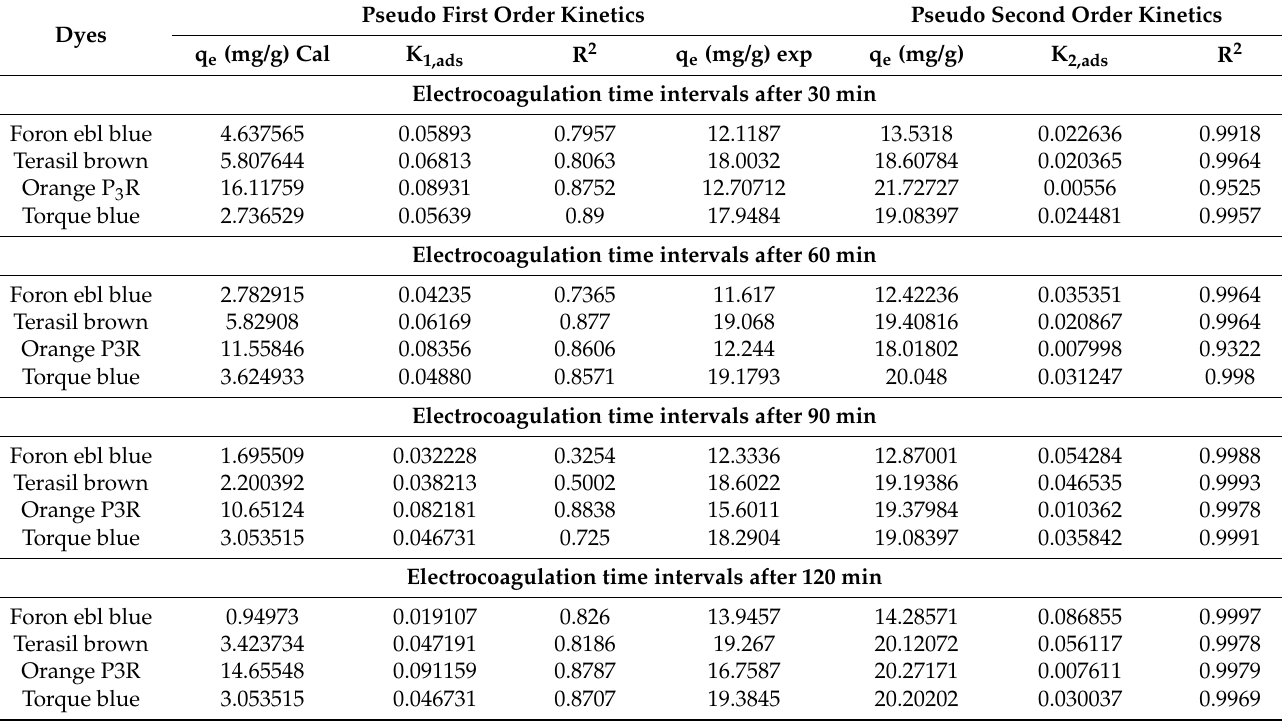
Table 3. Pseudo-first-order kinetics and Pseudo-second-order kinetics parameters of all four dyes at electrocoagulation time intervals (5, 10, 15, 20, 30 min) after a shaking period (30, 60, 90, 120, 180 min) using non-calcinized